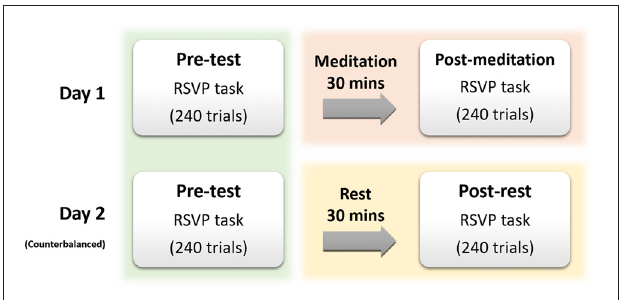
FIGURE 1 | Experimental time-line. Two days of testing were used for each participant, with the order of meditation and rest balanced for groups and